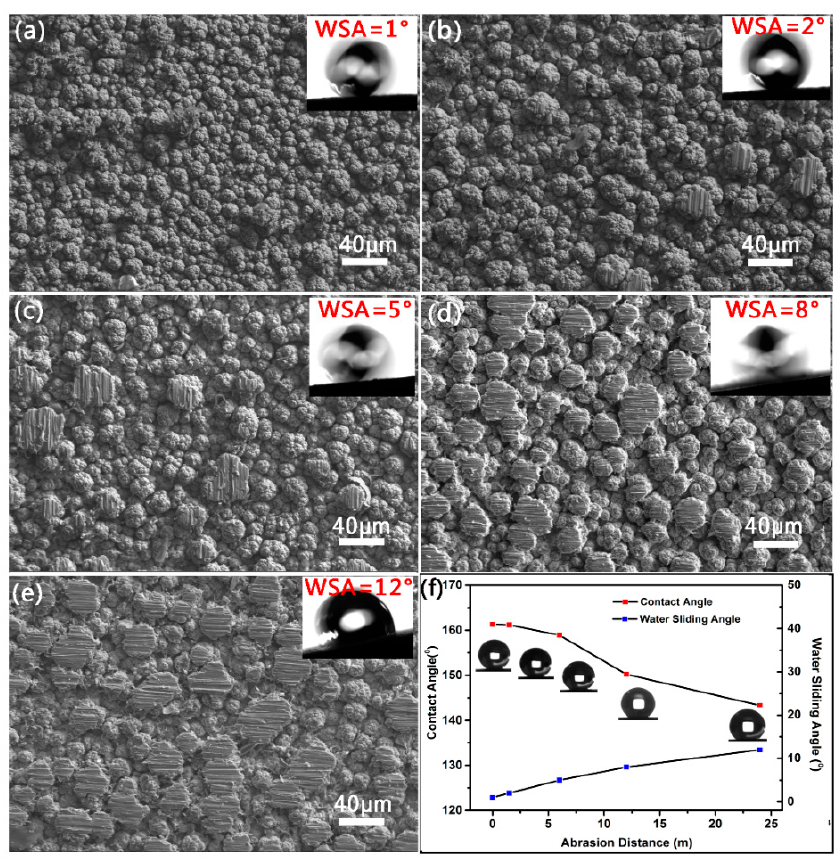
Figure 6. SEM images for ( a ) super-hydrophobic Co–Ni coating before abrasion and after abrasion under the applied pressure of 5 kPa for ( b ) 1.5 m, ( c ) 6 m, ( d ) 12 m, and ( e ) 24 m; ( f ) The water contact angle and water sliding angle variations on these surface with the abrasion distance. The insert images in ( a ) to ( e ) are the profiles of a water droplet sliding on the Co–Ni coating with different water sliding angles.